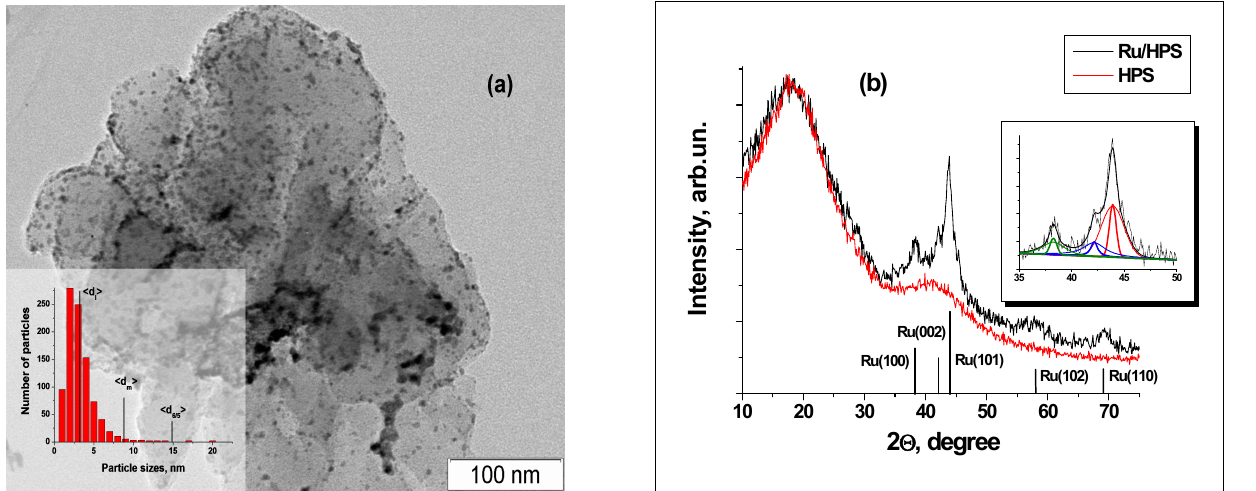
Figure 6. ( a ) TEM photo for the Ru/HPS sample with Ru particle size distribution. ( b ) XRD patterns for Ru/HPS (black line) and initial HPS (red line) samples. The vertical black lines indicate Ru reflexes (JCPDS 06-0663). Differential XRD data for Ru with peaks fitting by narrow and wide components are shown on the inset. Table 3. TEM and XRD data for noble nanoparticles supported on HPS and DLS data for prepared sols from these samples.